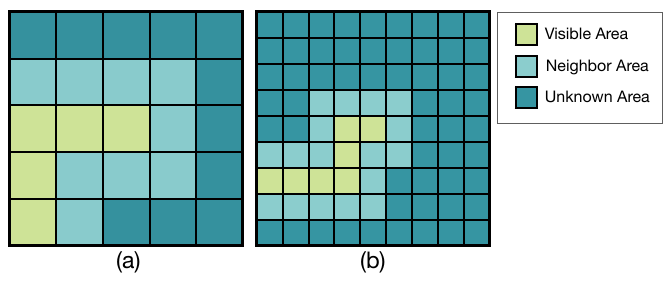
Figure 3. Prediction window examples with size of: ( a ) 5 × 5; and ( b ) 9 ×